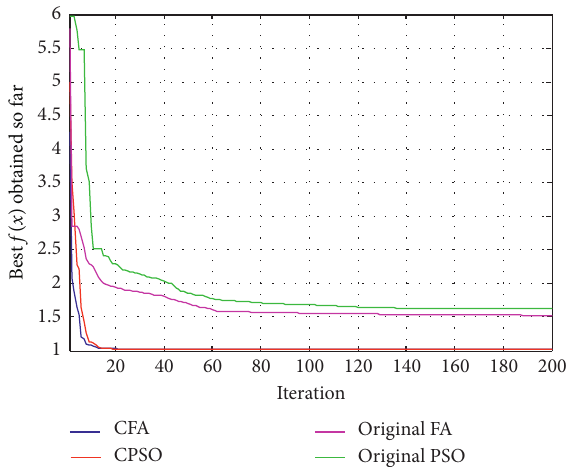
Figure 2: The convergence curve of the best f ( x ) obtained so far by original PSO, original FA, CPSO, and CFA for problem 1.